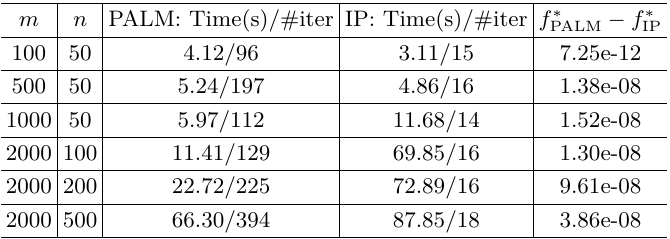
Figure 9 Convergence history (iterations) for PALM (green) and interior point method (black). The experiment shown is for τ = 0 . 1 , κ = 1. This behavior is representative; in particular the proposed IP method converges in fewer than 20 iterations in all cases. Table 3 Timing comparison (in seconds) of PALM and IP for the quantile Huber family. Columns 2 and 3 show total run time and number of iterations of PALM and IP; column 3 plots difference in final objective values. IP finds lower objectives, but PALM is faster for larger problems. A large-scale implementation of IP that uses iterative methods in each iteration would help with the scaling